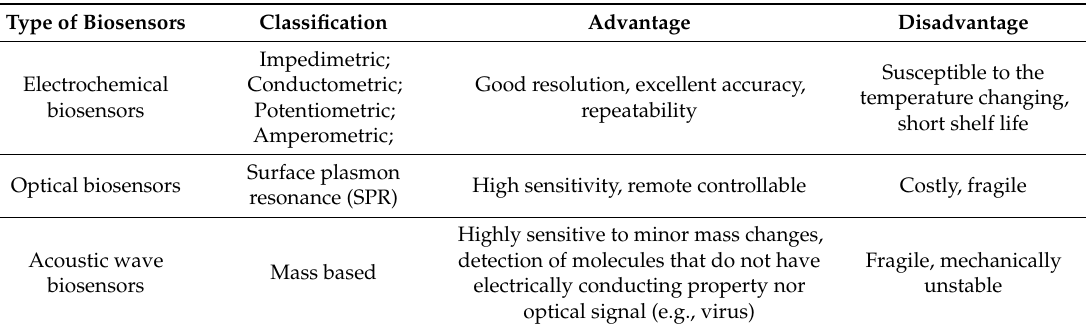
Table 8. Advantages and disadvantages of various biosensors.